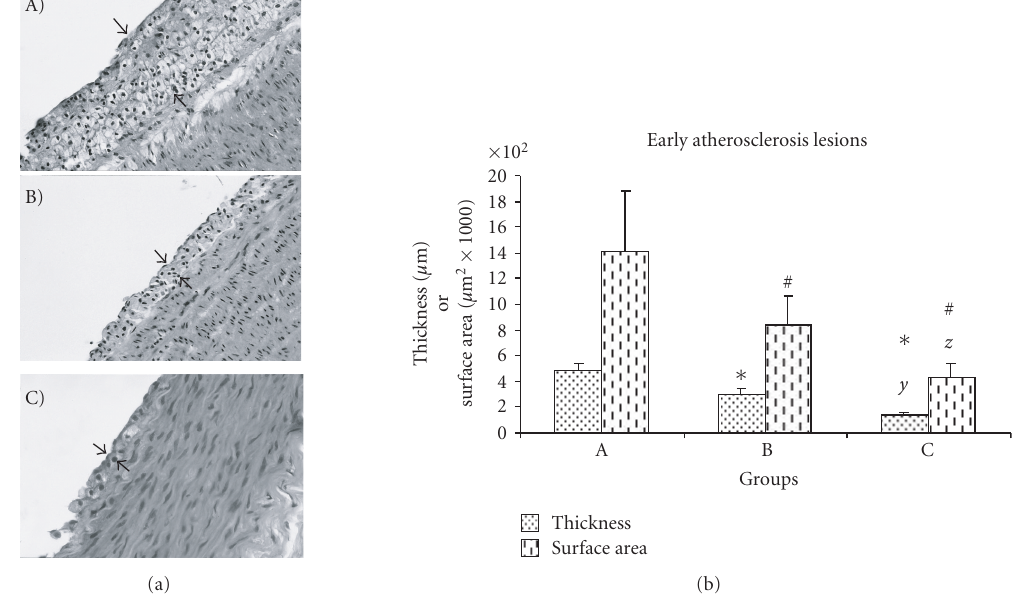
Figure 2: (a) Optic microphotographs ( × 200 for A and B; × 400 for C) of representative atherosclerosis lesions of aortic wall sections stained with haematoxylin and eosin. The arrows indicate the observed atherosclerosis lesions. A: atherogenic diet, B: atherogenic diet enriched with OOPL, C: atherogenic diet enriched with PPL. (B) Thickness and surface area of early atherosclerosis lesions of the three experimental groups, expressed as mean ± sd; ∗ Significant di ff erence for groups B and C versus group A in atherosclerosis lesion thickness ( P < . 05). # Significant di ff erence for groups B and C versus group A in atherosclerosis lesion area ( P < . 05). y , z Significant di ff erence for group C versus group B in atherosclerosis lesion thickness and area respectively ( P < . 005). Statistical analysis was based on independent sample t